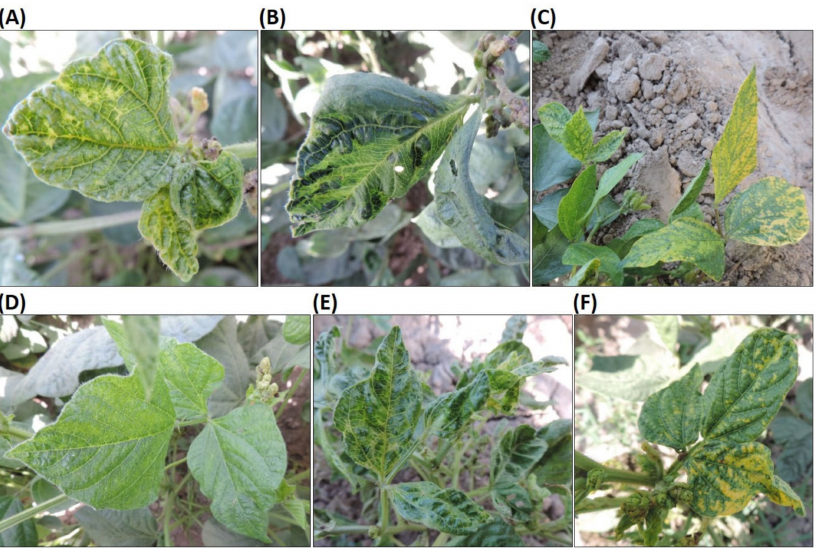
Figure 2. Symptoms caused by viral diseases on mung bean samples. ( A – C ) show the sample infected with CMV, while ( D – F ) are the sample infected with CMV and BCMV.